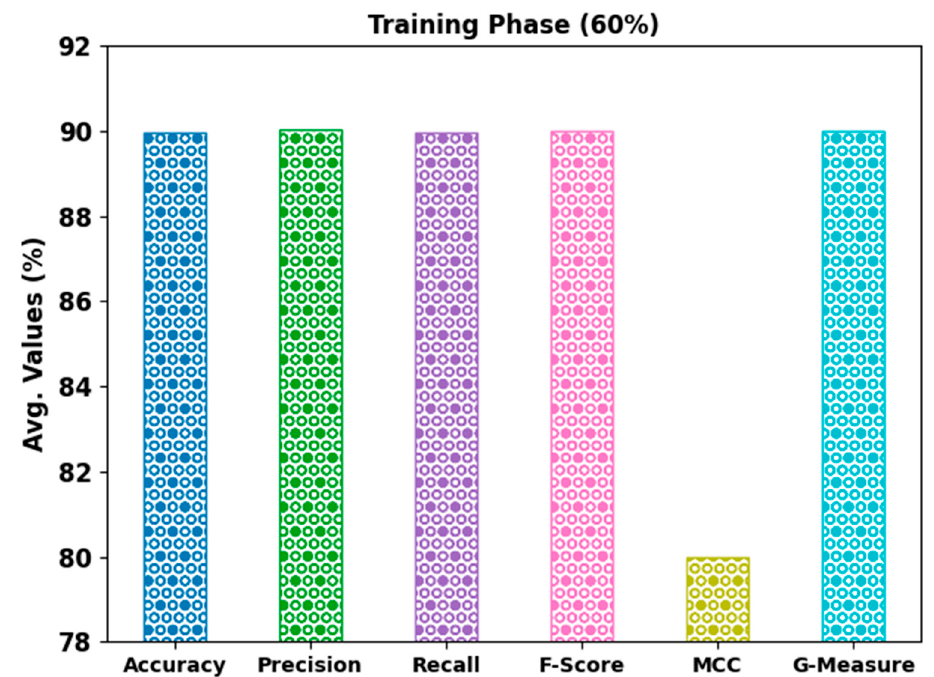
Figure 4. Average analysis of AHBATL-MNC approach under 60% of TR database. Figure 5 reveals a comprehensive classifier outcome of the AHBATL-MNC system on 40% of the TS database. The outcomes show that the AHBATL-MNC approach properly classified the mitosis and nonmitosis class images. It can be seen that the AHBATL-MNC method reached average accu bal of 96.77%, prec n of 96.77%, reca l of 96.77%, F score of 96.67%, MCC of 93.55%, and G measure of 96.72%.